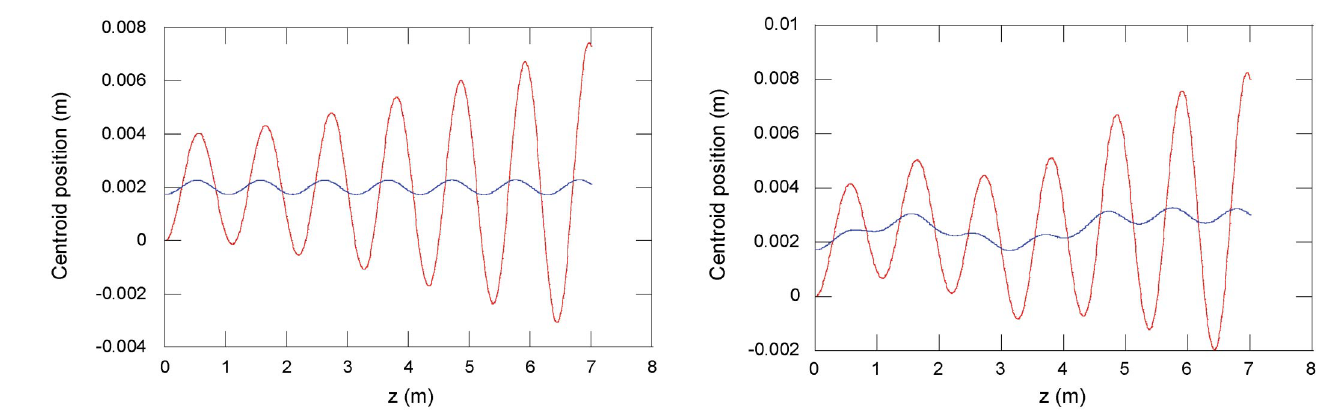
FIG. 11. (Color) Ion-hose calculation in the IFR using method 2. The red line shows the electron slice centroid and the blue line shows the ion